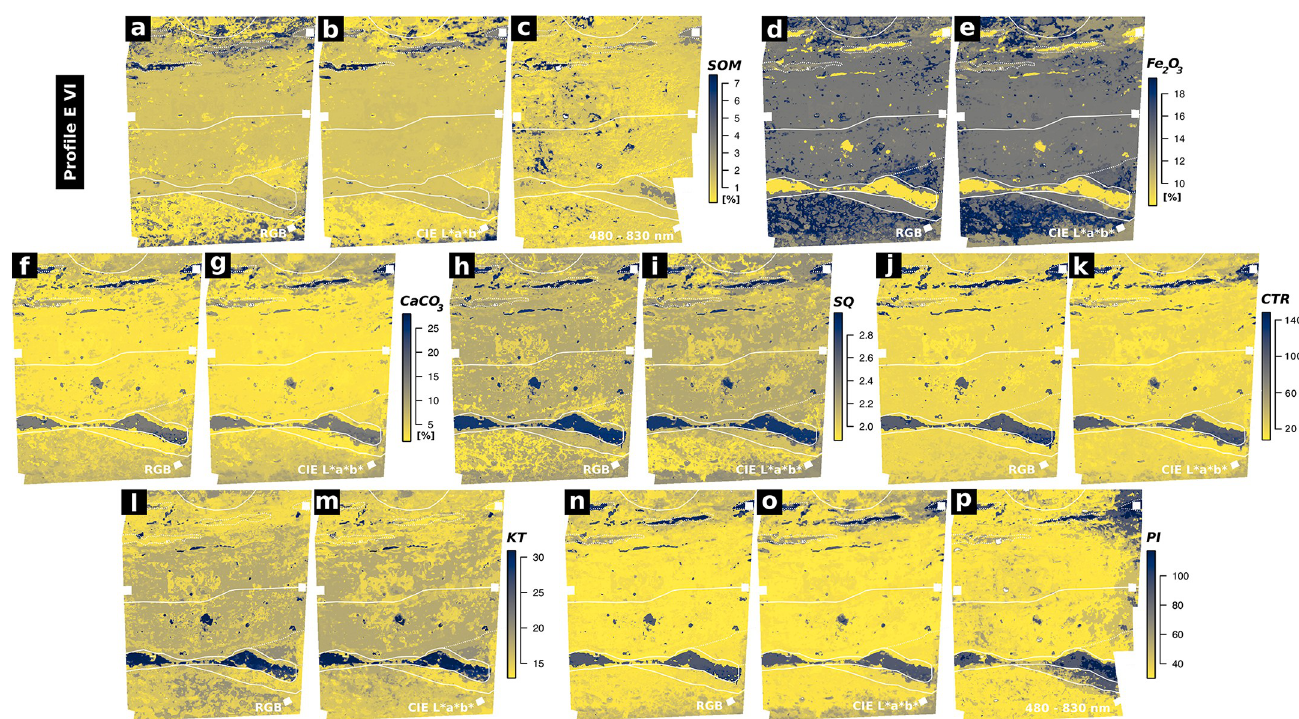
Fig 7. Predicted sediment properties of Profile EVI. Only models with a cross-validated R 2 greater than 0.8 and a high correlation between the respective prediction map and the on-site stratigraphic delineation (white lines) are shown.